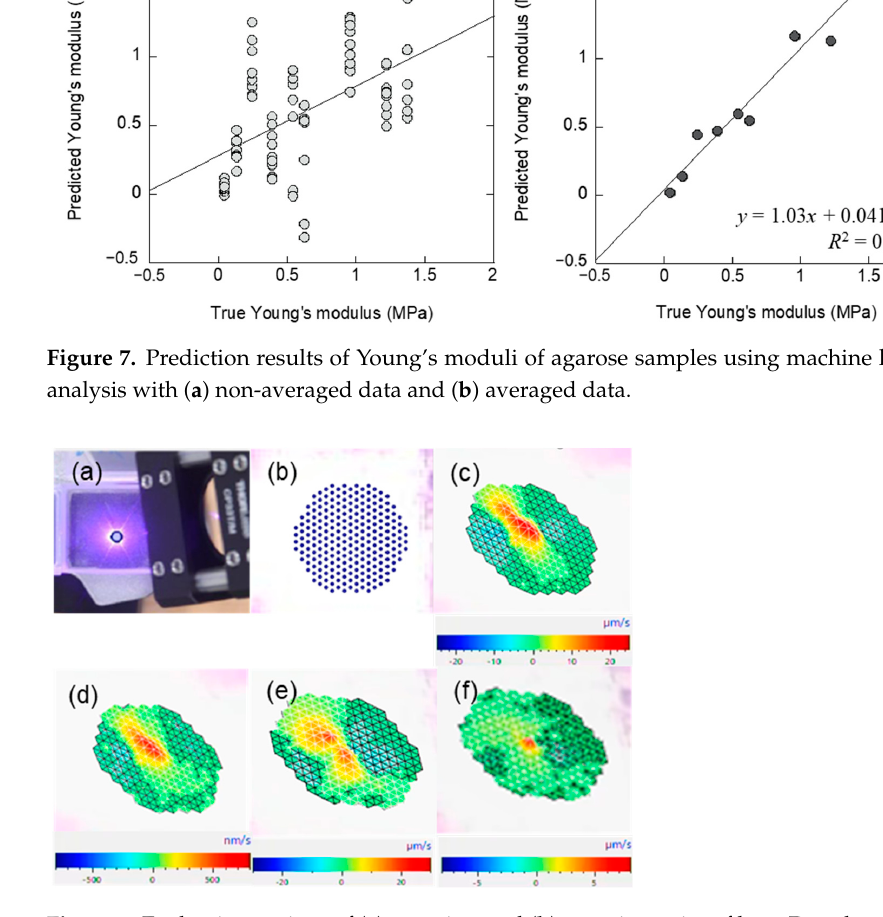
Figure 8. Evaluation settings of ( a ) overview and ( b ) scanning point of laser Doppler vibrometer, and behaviors of forced vibration obtained by L-RFA on agarose samples at different Young’s mod- uli as ( c ) 924 Hz at 0.042 MPa, ( d ) 1848 Hz at 0.042 MPa, ( e ) 924 Hz at 1.2 MPa, and ( f ) 1848 Hz at 1.2 MPa, respectively.